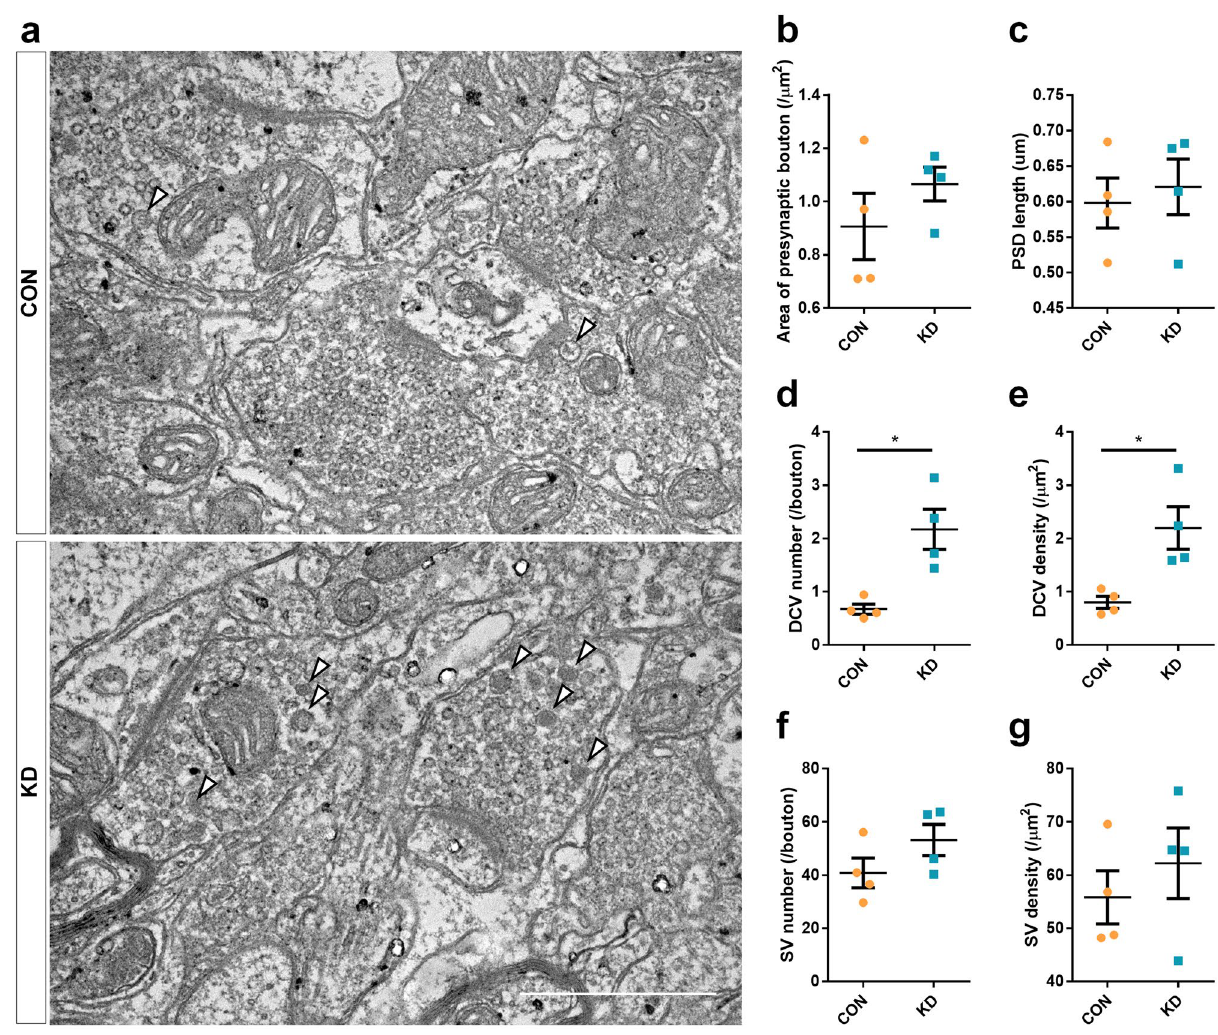
Figure 3. DCVs are accumulated in IPN of MHb CAPS2 knockdown mice. ( a ) Representative electron micrographs of IPN slices from the mice injected with AAV-sh-vehicle (CON) or AAV-sh-CAPS2 (KD). Closed arrowheads indicate DCVs. ( b–g ) MHb CAPS2 knockdown effect in IPN synapses was examined by measuring the area of presynaptic bouton, PSD length, DCV, SV number, and density. Decreased CAPS2 expression in the MHb led to increased DCV number and density in the IPN. Data represent mean ± SEM, * P < 0.05 (CON, n = 4; KD, n = 4; 50 synapses counted and averaged per mice; presynaptic area: P = 0.486; PSD length: P = 1.000; DCV number: P = 0.029; DCV density : P = 0.029; SV number: P = 0.200; SV density: P = 0.686; Mann–Whitney U -test; Scale bars, 1 group; Mann–Whitney U -test; SV number: 40.86 ± 11.20 vs. 53.20 ± 11.77, P = 0.200; SV density: 55.83 ± 9.96 vs. 62.24 ± 13.31, P = 0.686; Fig. 3a, f, and g). This implied that the CAPS2 reduction impairs DCV exocytosis and leads to accumulation of DCVs in the MHb terminals in the IPN. MHb CAPS2 knockdown affects c‑Fos and p‑ERK levels in the IPN. Since DCVs accumulate in syn- aptic bouton of the MHb in the IPN by down-regulation of MHb CAPS2, we measured c-Fos and p-ERK levels as neuronal activity markers in the IPN using Western blot and immunohistochemistry (IHC). In Western blot analysis using IPN lysates containing the presynaptic components derived from the MHb, CAPS2 protein levels were decreased in the knockdown group (n = 5 for each group, Mann–Whitney U -test; CAPS2: 1.00 ± 0.33 vs. 0.41 ± 0.20, P = 0.016; Fig. 4a and b). Protein levels of c-Fos and p-ERK in the IPN were also decreased, without affecting expression of total ERK (n = 5 for each group, Mann–Whitney U -test; c-Fos: 1.00 ± 0.39 vs. 0.34 ± 0.13, P = 0.016; p-ERK: 1.00 ± 0.16 vs. 0.57 ± 0.16, P = 0.008; ERK: 1.00 ± 0.15 vs. 0.79 ± 0.24, P = 0.222; Fig. 4a and c–e). From IHC, the number of c-Fos-positive cells was also decreased in MHb CAPS2 knockdown mice (n = 6 for each group, Student’s t -test; c-Fos-positive cells: 8.17 ± 3.56 vs. 3.83 ± 2.78, T (10) = -2.351 P = 0.041; Fig. 4f and g). These results suggest that presynaptic accumulation of DCV leads to decreased IPN neuronal activity.